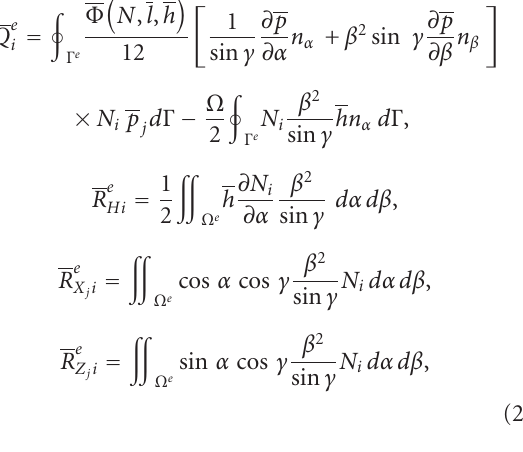
Equation (20) is the modified Reynolds equation for a conical journal bearing system operating with micropolar lubricant. For the values of micropolar parameters, l = ∞ , N = o , (20) changes into the form applicable for Newtonian lubricant as given in [14,